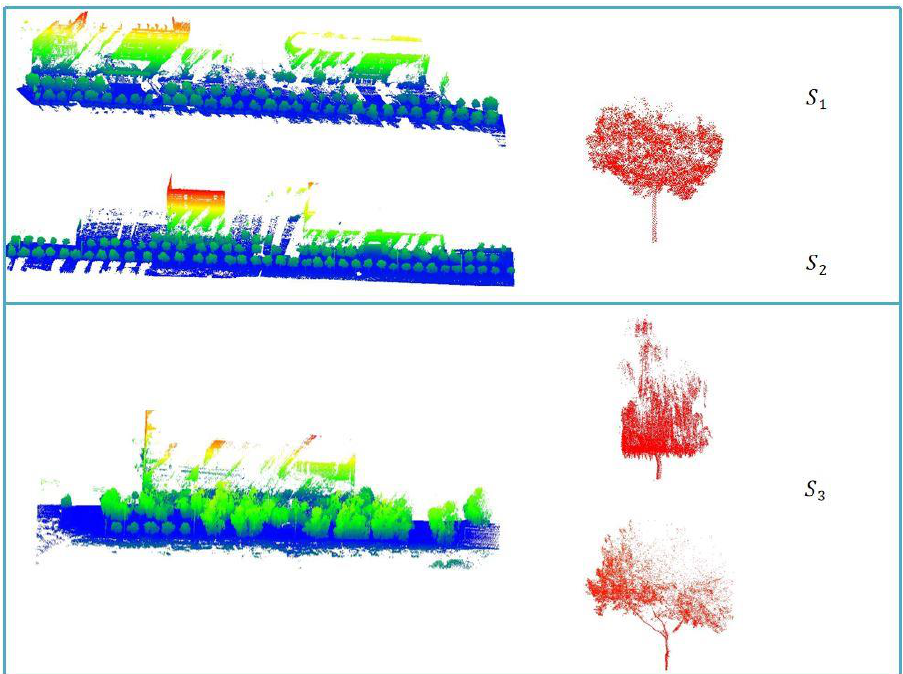
Figure 6. Overview of the study area: On the left is the schematic diagram of the three study areas, and on the right is the main tree species in each study area (in the study areas S 1 and S 2 , the tree species is small poplar tree; S 3 is willow and large poplar tree).